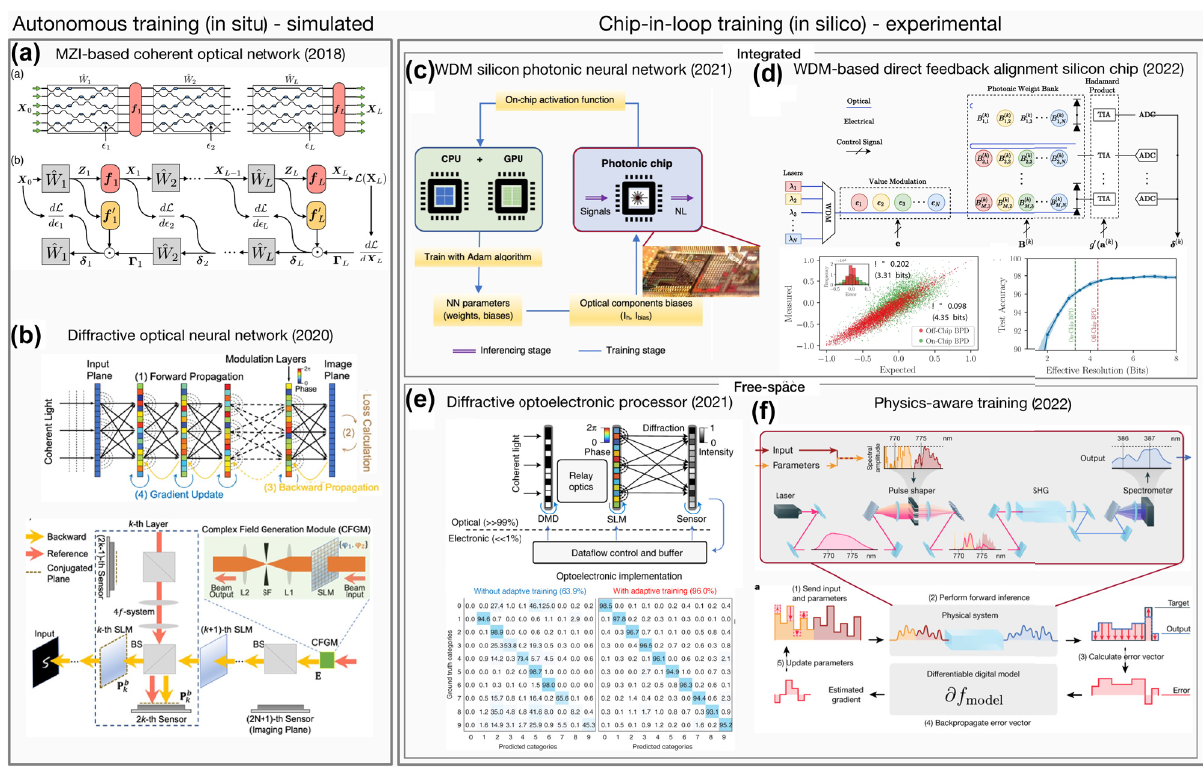
Figure 2: Proposals for training photonic hardware. (a) and (b) Simulations of fully autonomous online learning proposals for gradient descent via backpropagation in (a) integrated photonics [59] and (b) free space [56]. (c)–(f) Experimentally demonstrated hardware-in-the-loop. (c) The measured activation functions are used in the hardware-aware training of micro-ring resonator based neuromorphic device for optical signal processing [61]. (d) Integrated implementation of DFA where the backward pass is computed on-chip [60]. (e) Fine-tune training of the network increases the accuracy of handwritten digit recognition from 63.9% to 96% [68]. (f) Training of a free-space physical neural network where the calculation of the forward pass in the device prevents accumulation of errors that can happen in offline training